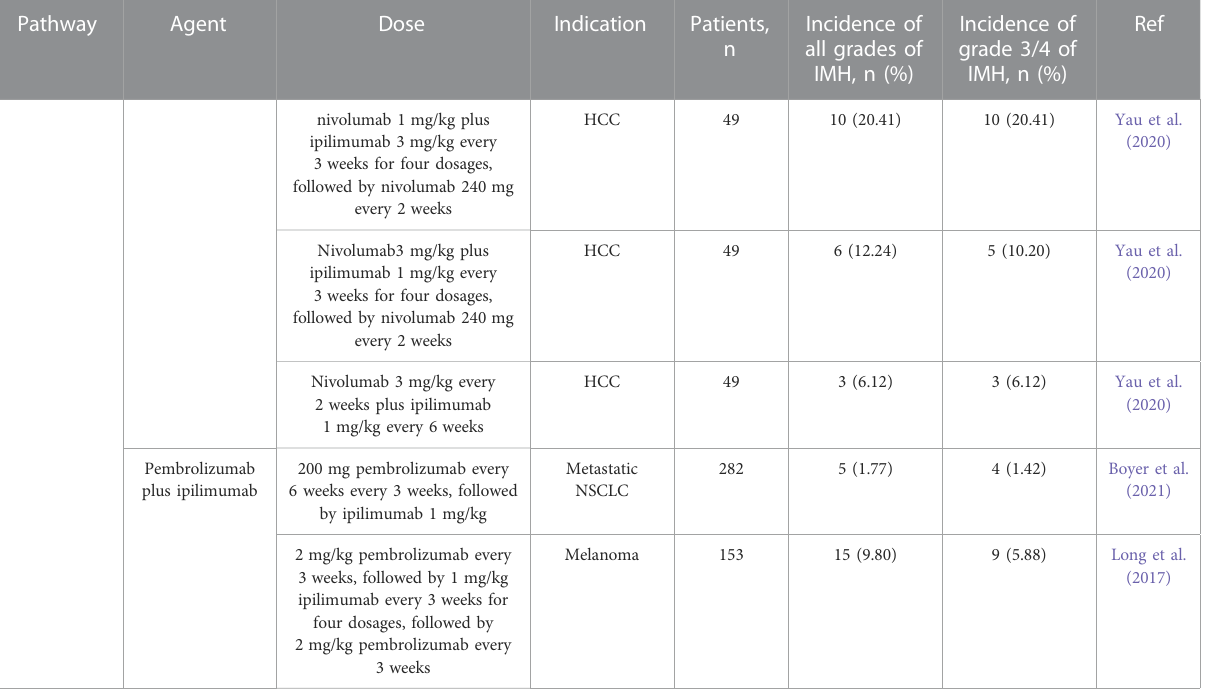
TABLE 2 ( Continued ) Incidence of immune-mediated hepatitis according to different treatment regimens with immune checkpoint